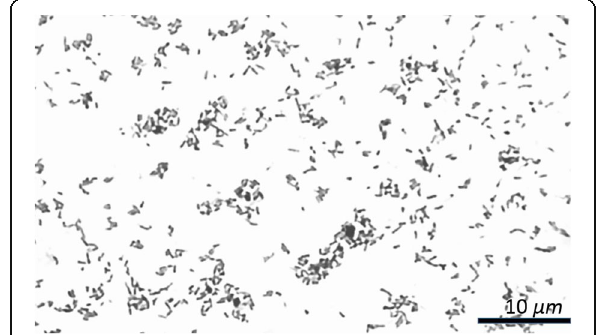
Fig. 1 Photomicrograph of cells of B. abortus strain Ba Col-B012. Cells were grown on trypticase soy agar and brain infusion agar supplemented with 5% horse serum, this media was incubated at 37 °C for 48